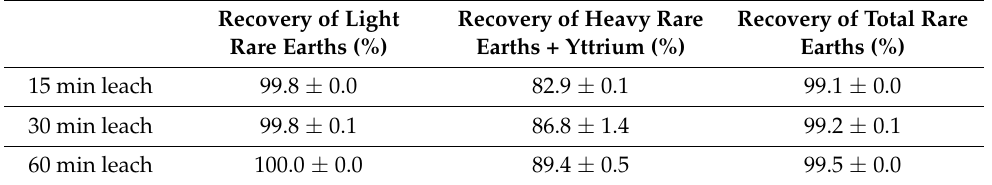
Table 6. Overall light and heavy rare earth dissolution (%): Bunbury monazite.